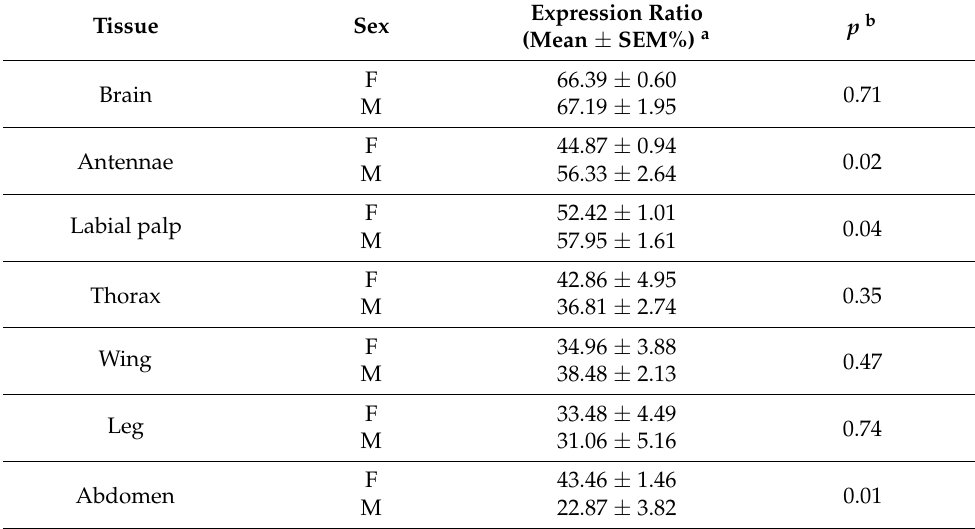
Table 3. Expression ratio of 5-HT7S in adult tissues of Mythima separata